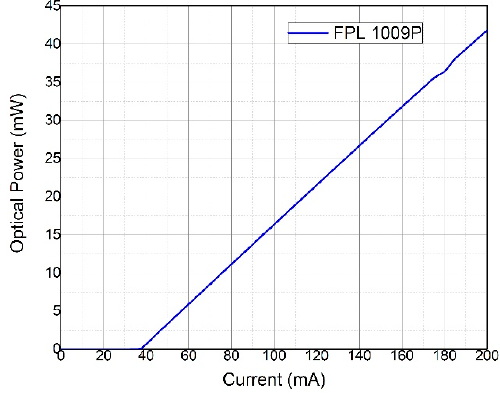
Figure 3. Power–current (L–I) curve of the MLD.